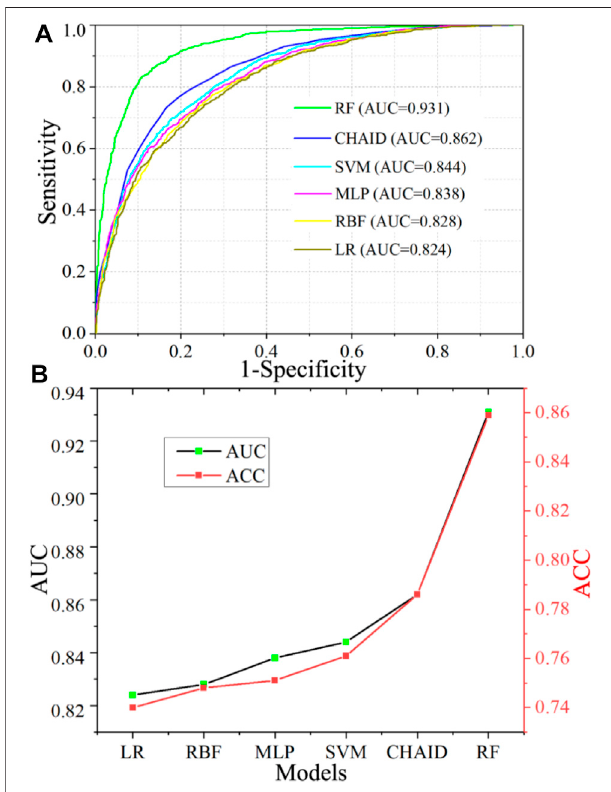
FIGURE8| Predictionratesofeachmodelperformance. (A) AUCvalues of all models. (B) ACC performance of all models.